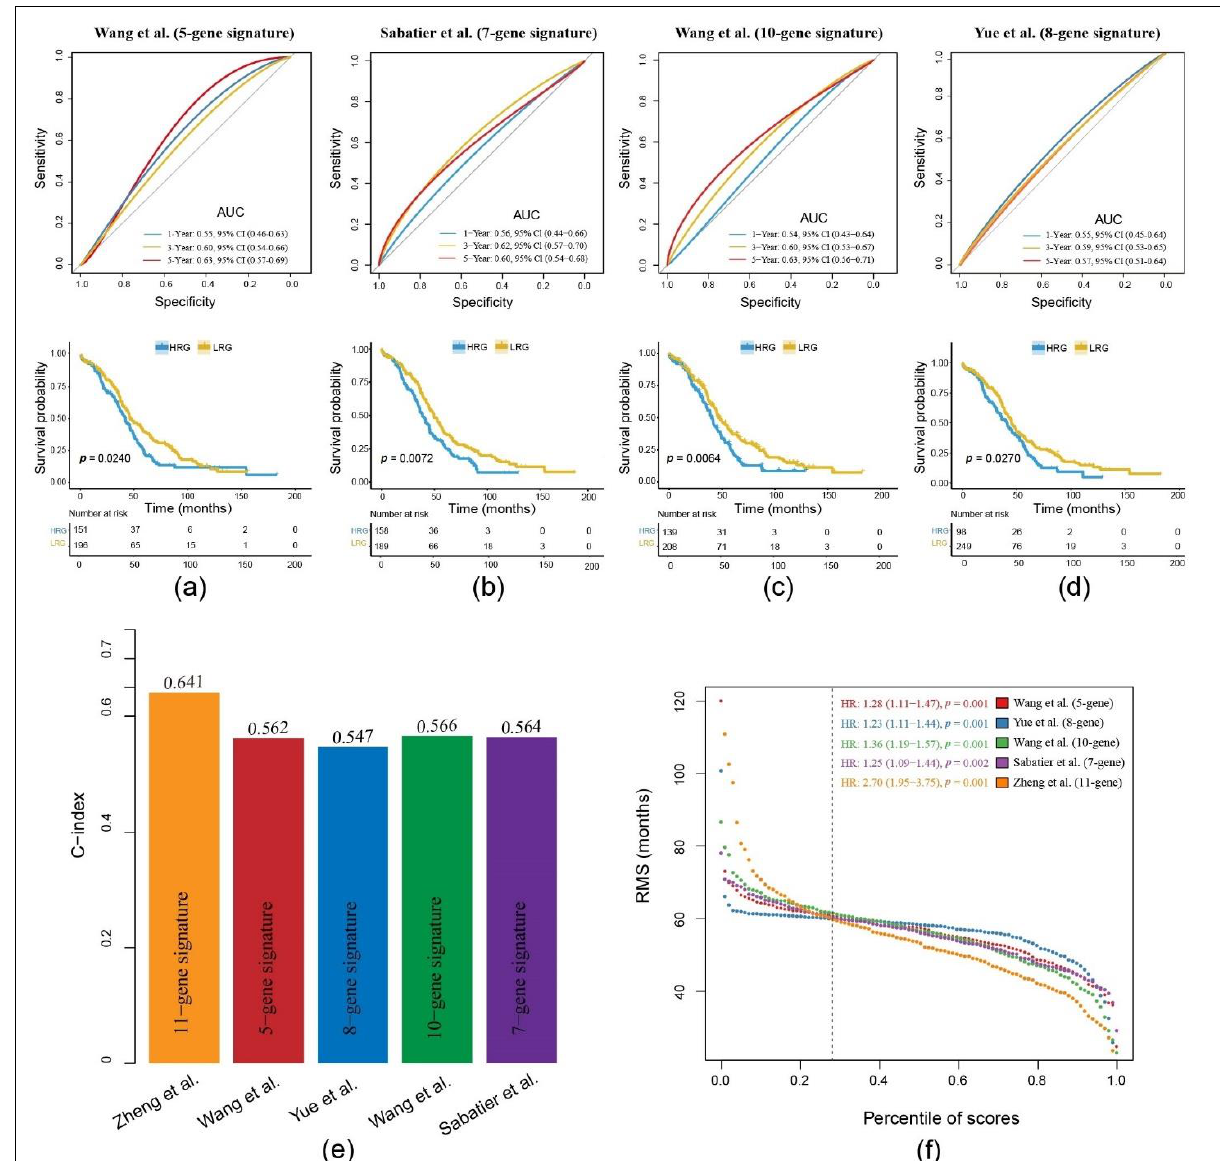
curve analysis (DCA) curves can evaluate the clinical benefit of the nomograms and their potential scope of application. Black indicates that all samples are negative and none are treated, therefore the net benefit is zero. Gray indicates that all samples are positive and all are treated. The x-axis represents the threshold probabilities.